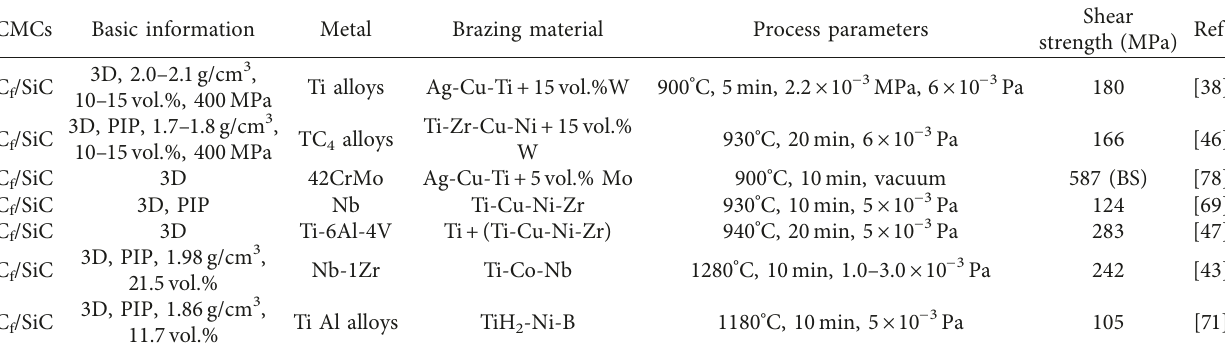
Table 7: Brazing of C f /SiC composites to metals with high-temperature